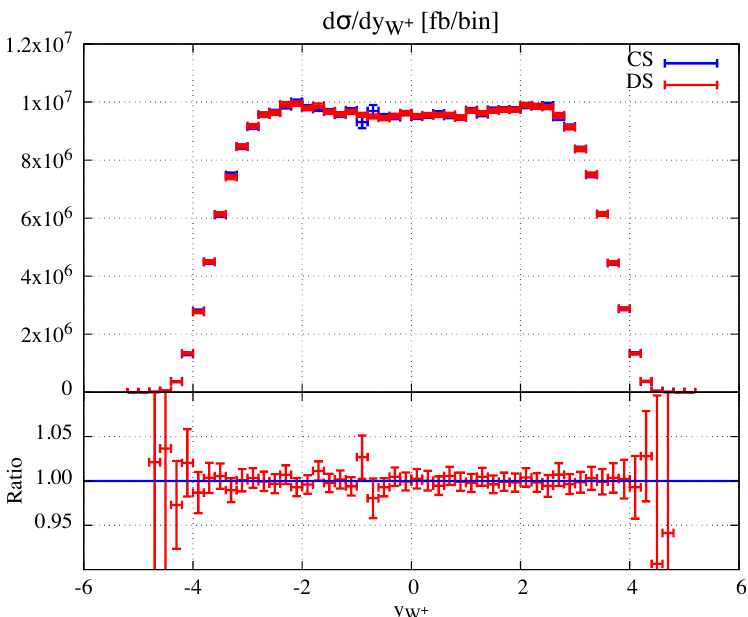
Figure 8. Rapidity distribution of the W + boson in proton-proton collisions at 8 TeV center-of- mass energy ( q ¯ q -channel only). The renormalization and the factorization scale are both equal to µ = 80 GeV, while α S ( µ ) = 0 . 12264887 , m W = 80 . 398 GeV and G F = 1 . 16639 · 10 − 5 GeV − 2 . The Dual Subtraction (DS) results are shown in red, while the Catani-Seymour (CS) ones in blue. The error bars correspond to the statistical error given by the Monte Carlo